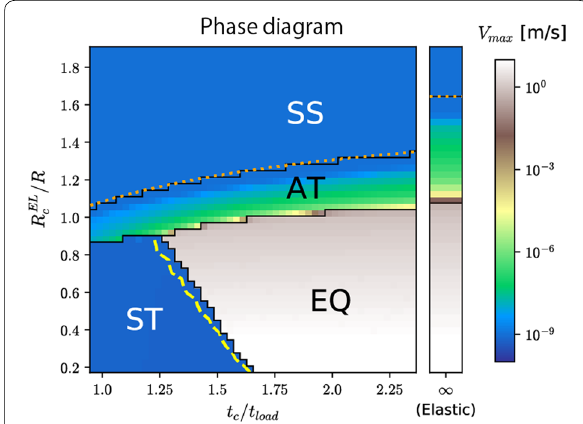
Fig. 6 Phase diagram of the fault behavior and V max as a function of t c / t load and R EL c / R . EQ earthquakes, AT aseismic transients, SS steady slip, ST stuck. The boundaries of these behaviors are indicated by black lines. The initial slip rate in the rate-weakening patch is V ini = 0.999 V pl . The yellow dashed line represents the critical t cr estimated from the divergence of t rec (Fig. 5). The relaxation time orange dotted line indicates a theoretical boundary between SS and AT derived via a linear stability analysis described in “Linear stability (cid:31) analysis of a spring–slider–dashpot model” section. Elastic cases ( t c = ∞ ) are shown in a right thin